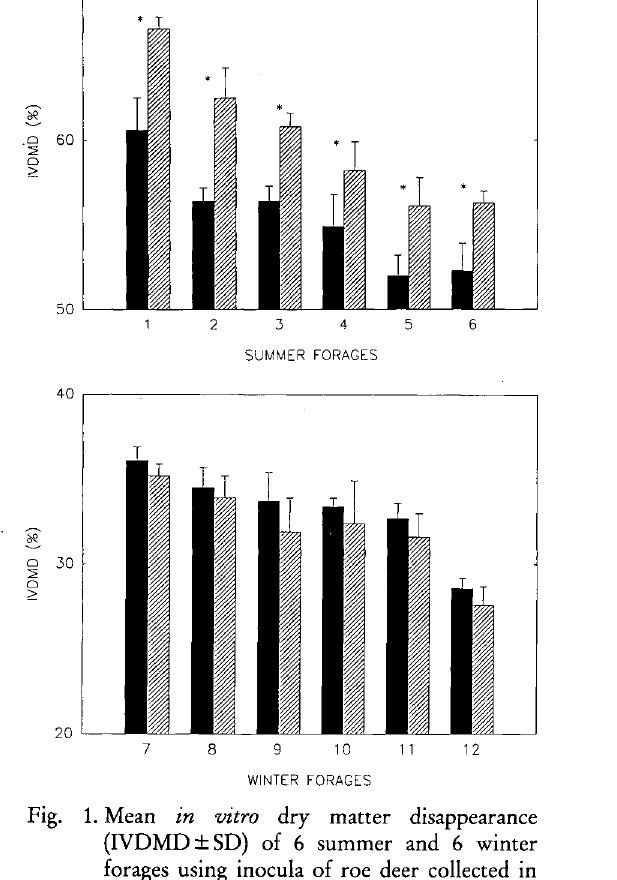
Fig. 1. Mean in vitro dry matter disappearance (IVDMD ±SD) of 6 summer and 6 winter forages using inocula of roe deer collected in February (filled bars) and in June and Au gust (hatched bars). Asterisks indicate signifi cant seasonal difference for each